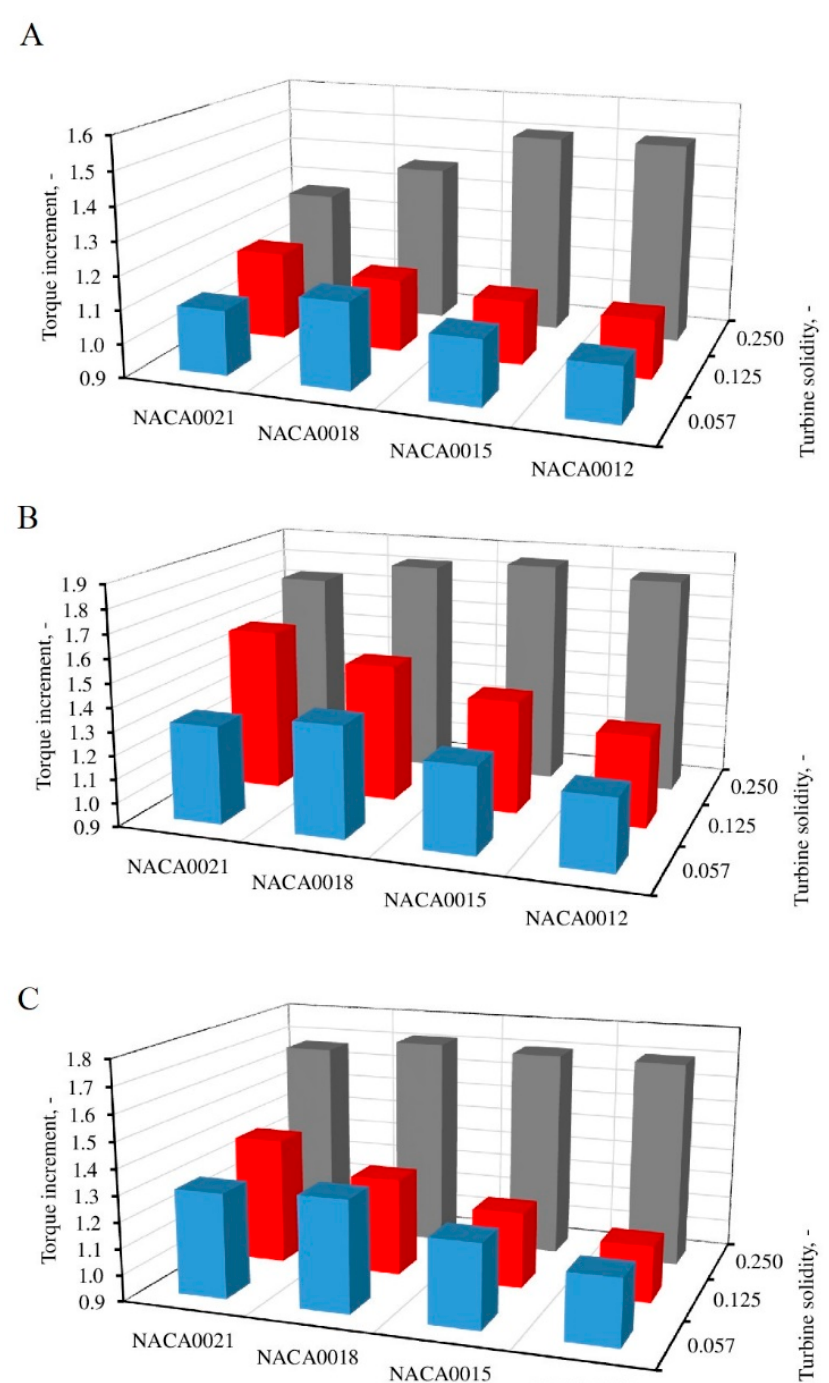
Figure 18. Increment of the torque value for optimal length of GFs for all investigated turbine configurations: ( A ) inward GF, ( B ) outward GF, ( C ) fish tail.